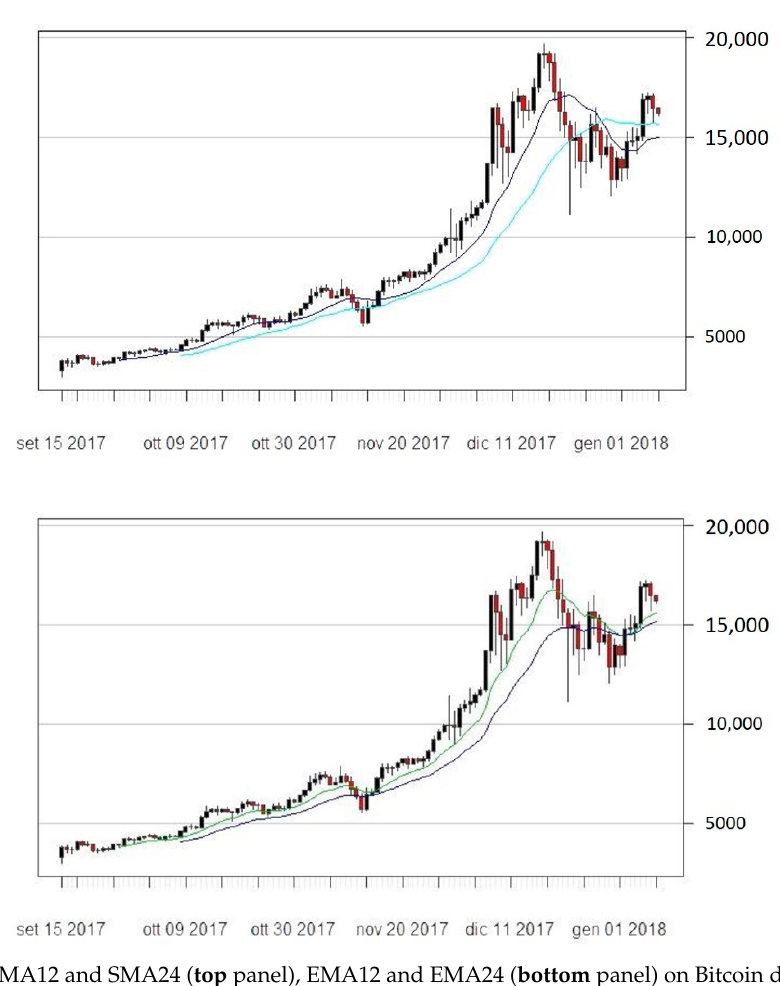
Figure 4. SMA12 and SMA24 ( top panel), EMA12 and EMA24 ( bottom panel) on Bitcoin daily prices.